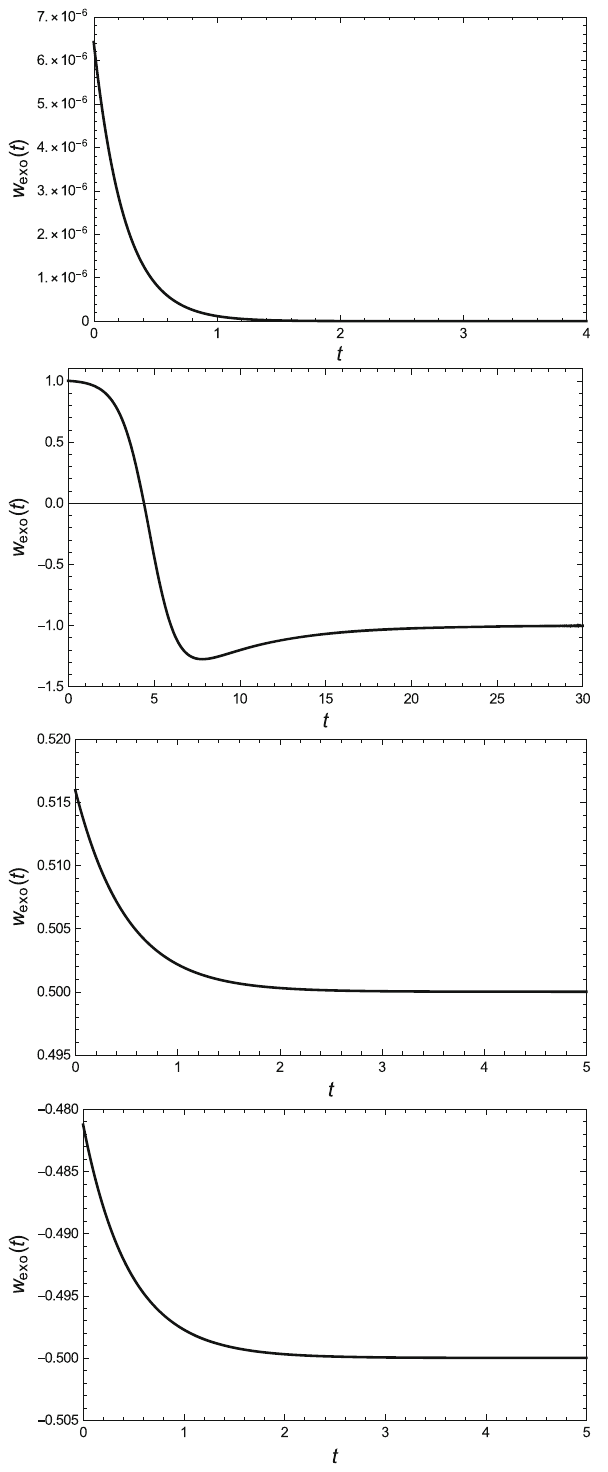
Fig. 8 EoS of the exotic fluid as a function of cosmic time. m and n are chosen as in Fig. 4, while the parameter s is fixed at 0 . 1. The graph on the top shows evolution of ω exo for ω = 0; the graph second from the top shows the evolution for ω = 1; the graph second from the top shows the evolution for ω = 1 . The graph on the bottom is for ω = − 1 2